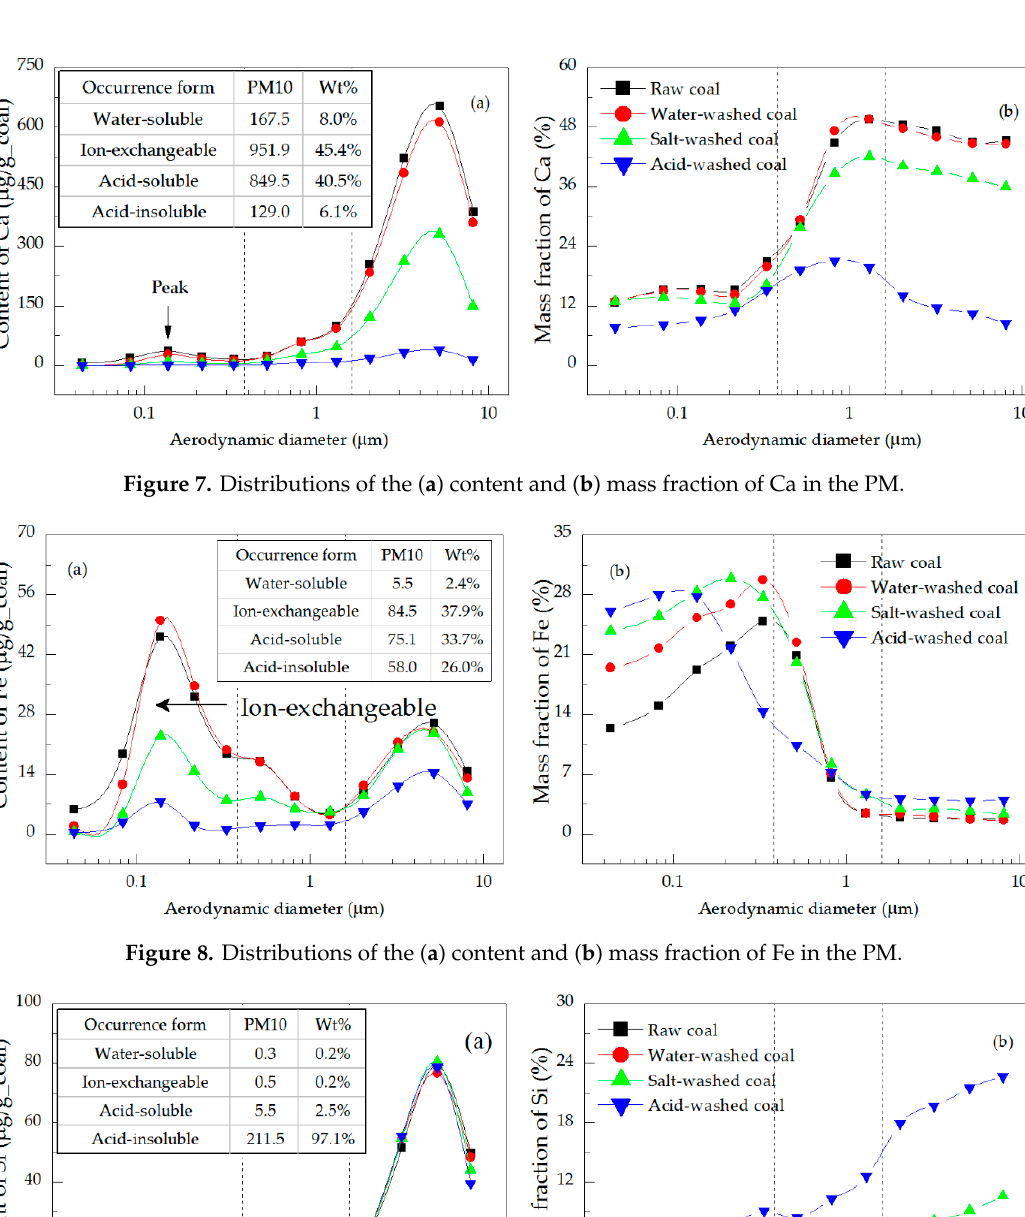
Figure 6. Distributions of the ( a ) content and ( b ) mass fraction of Mg in the PM.